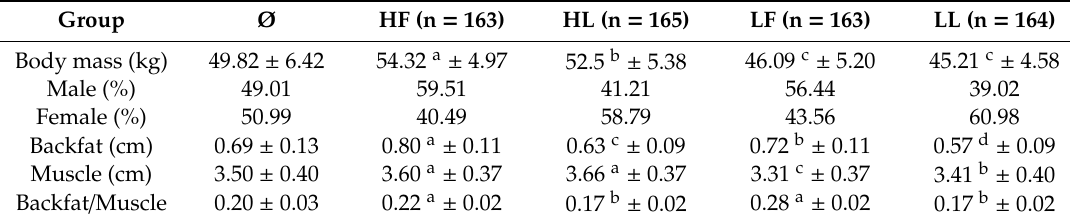
Table 5. Body composition and gender of the animals at the grouping time in Barn I. Group Ø